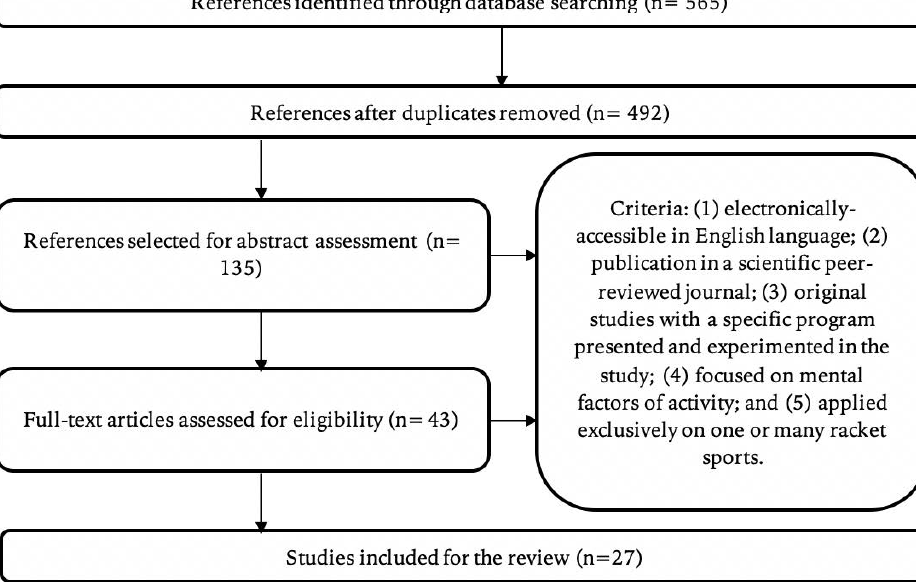
Figure 1 . Procedure of inclusion and exclusion of studies Data